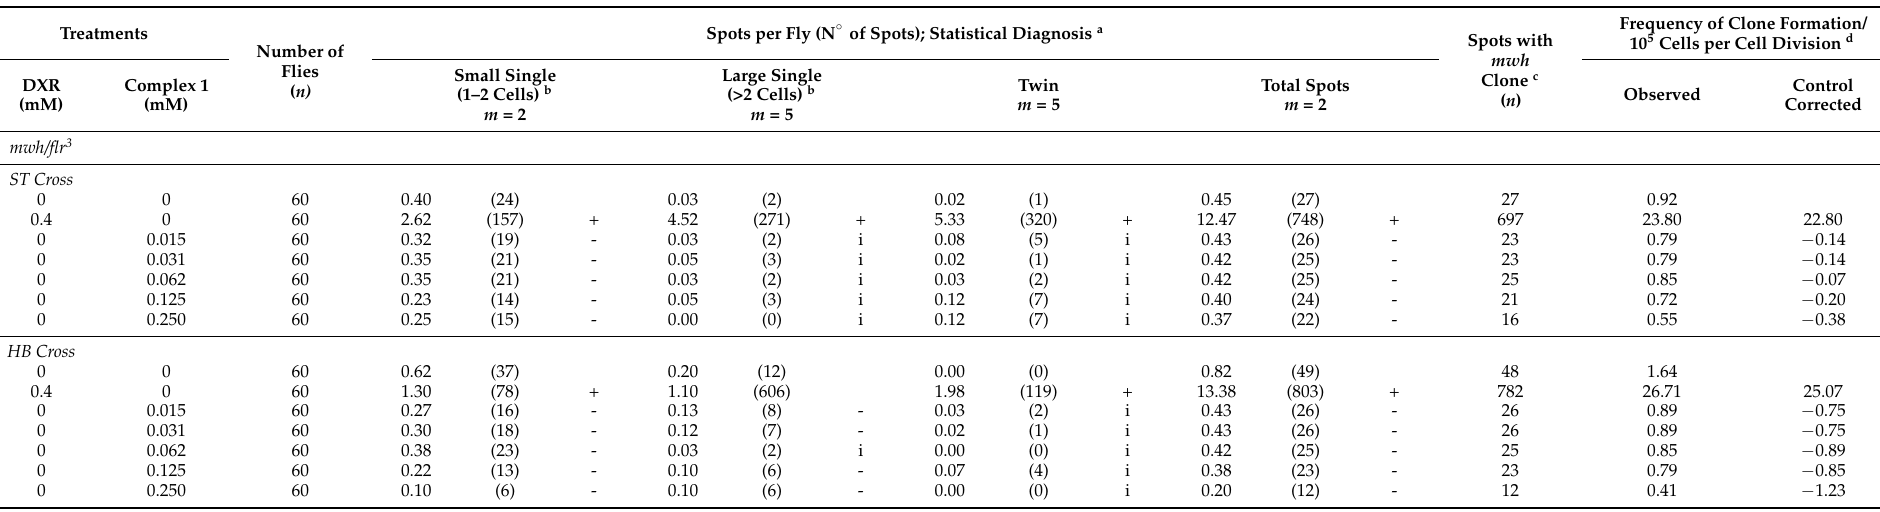
Table 1. Results obtained in the marked trans-heterozygous (MH) descendants of D. melanogaster derived from the standard (ST) cross and high-bioactivation (HB) cross treated with different complex 1 concentrations, negative control (reverse osmosis water) and positive control (0.4 mM